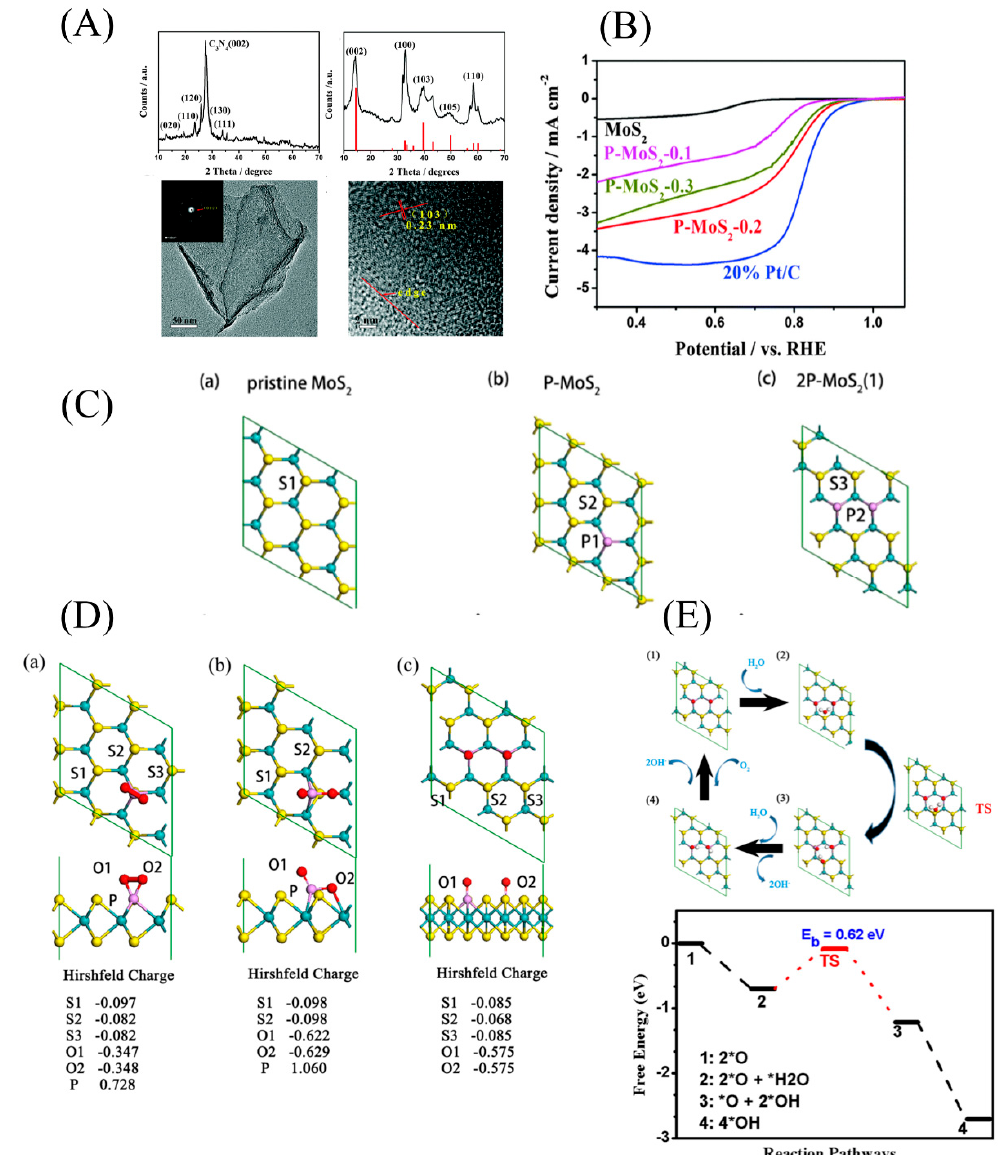
Figure 8. ( A ) X-ray diffraction (XRD) patterns of the MoO 3 /g-C 3 N 4 intermediate and ultrathin P-MoS 2 nanosheets and TEM and high resolution-TEM images of ultrathin P-MoS 2 nanosheets. (B ) ORR electrocatalysis for P-MoS 2 -0.1, P-MoS 2 -0.2, P-MoS 2 -0.3, MoS 2 , and 20% Pt/C catalysts. Reproduced with permission from [46] Copyright © 2021 The Royal Society of Chemistry. ( C ) Top view of the optimized structure of (a) pristine MoS 2 nanosheets, (b) single P-doped MoS 2 nanosheets, and (c) double P-doped MoS 2 nanosheets. ( D ) Top and side views of the optimized adsorption configurations of (a) O 2 -adsorbed P-MoS 2 , (b) 2O-adsorbed P-MoS 2 , and (c) 2O-adsorbed 2P-MoS 2 . The Hirshfeld charge values of the corresponding atoms are also given. ( E ) Optimized structure configuration of reactant, intermediates, and product (1–4) and the corresponding reaction pathways of the ORR on a 2P-MoS 2 sheet in an alkaline environment. Reproduced with permission from [88] Copyright © 2021 American Association for the Advancement of Science.